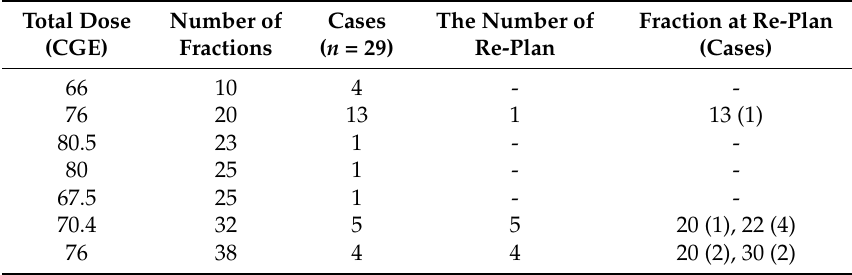
Abbreviations; CGE: cobalt Gray